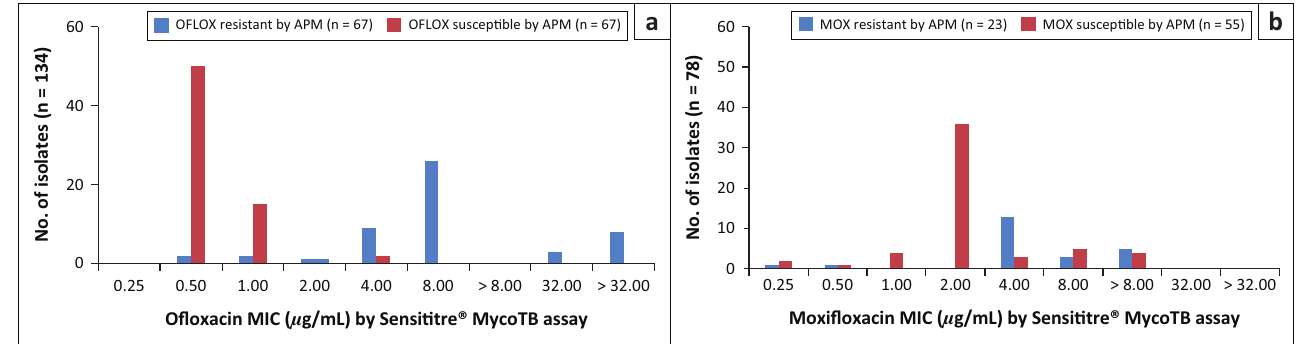
FIGURE 2: Distribution of isolates by minimum inhibitory concentration for ofloxacin and moxifloxacin, Inkosi Albert Luthuli Central Hospital, Durban, South Africa, January 2014 – June 2015. (a) Distribution of OFLOX-resistant and -susceptible isolates as determined by APM according to their MIC as determined by the Sensititre® MycoTB assay. (b) Distribution of MOX-resistant and - susceptible isolates as determined by APM according to their MIC as determined by the Sensititre® MycoTB assay.